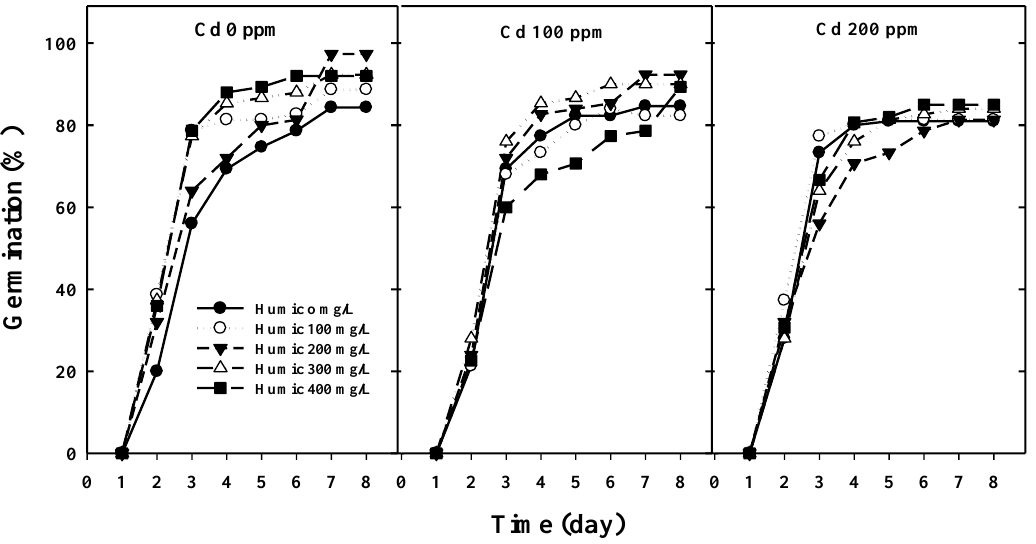
Figure 1. Effect of different concentrations of humic acid on the germination fraction of pumpkin seeds ( Cucurbita pepo L.) under cadmium (Cd) stress conditions.